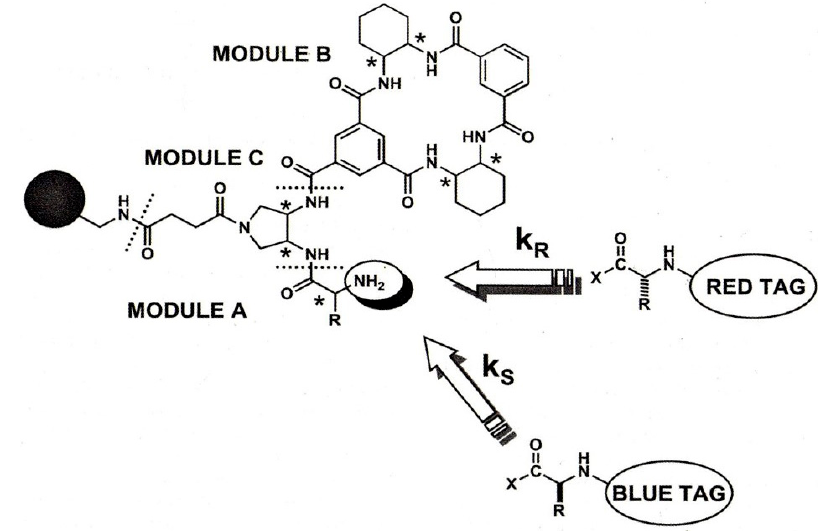
Figure 13. Structure of the multimodal receptor array and kinetic resolution of differently dye-tagged solid-supported amino acids from a 60-member library. Module A contains 15 different D - and L -amino acids, module B contains RR or SS diamine enantiomers, and the receptor module C contains RRRR or SSSS enantiomers resulting in 15 × 2 × 2 = 60 different library members [51]. Figure 13 reproduced with permission from [52].